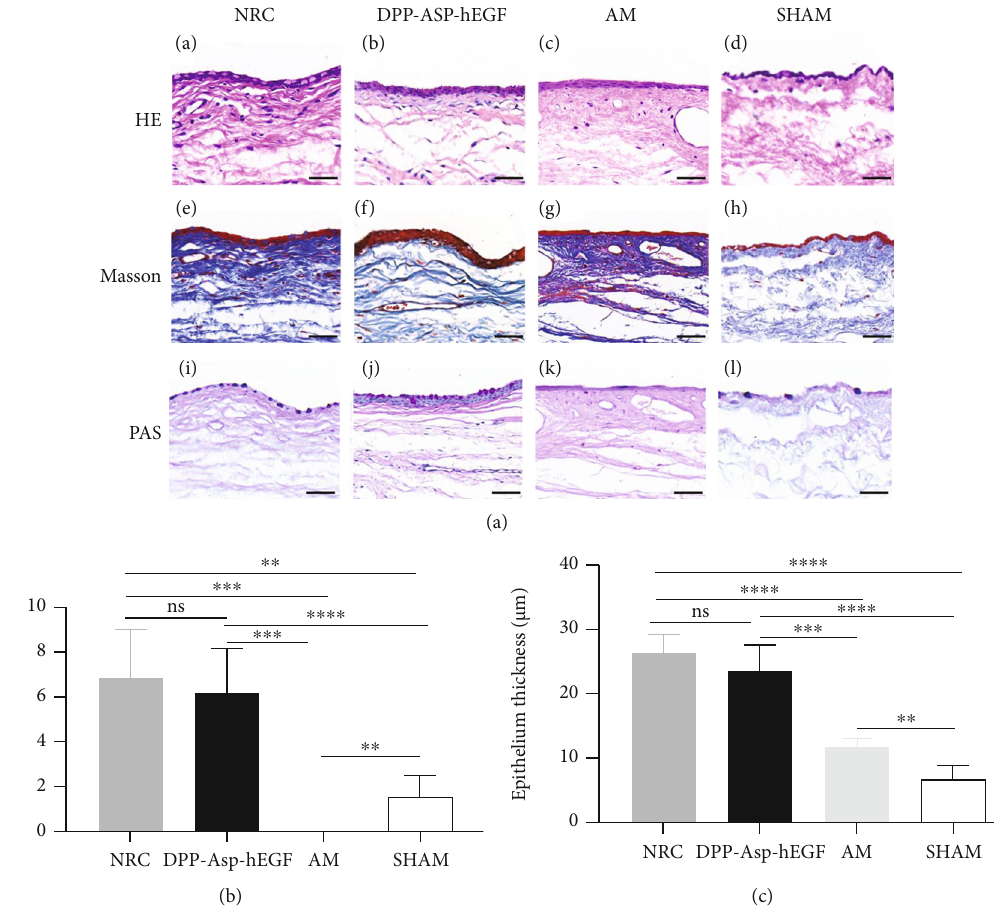
Figure 7: Histological analysis of sca ff olds transplanted in a rabbit conjunctival defect model in 28 days postoperatively. (a) The (A – D) HE staining, (E – H) Masson staining, and (I – L) PAS staining of (A, E, I) NRC or (B, F, J) DPP-Asp-hEGF or (C, G, K) AM or (D, H, L) sham conjunctival defects. Quantitative results of (b) repaired goblet cells and (c) epithelium thickness among three groups (data represented as mean value ± SD ; ∗∗∗ p < 0 : 005 , ∗∗∗∗ p < 0 : 001 ; scalebar = 50 μ m